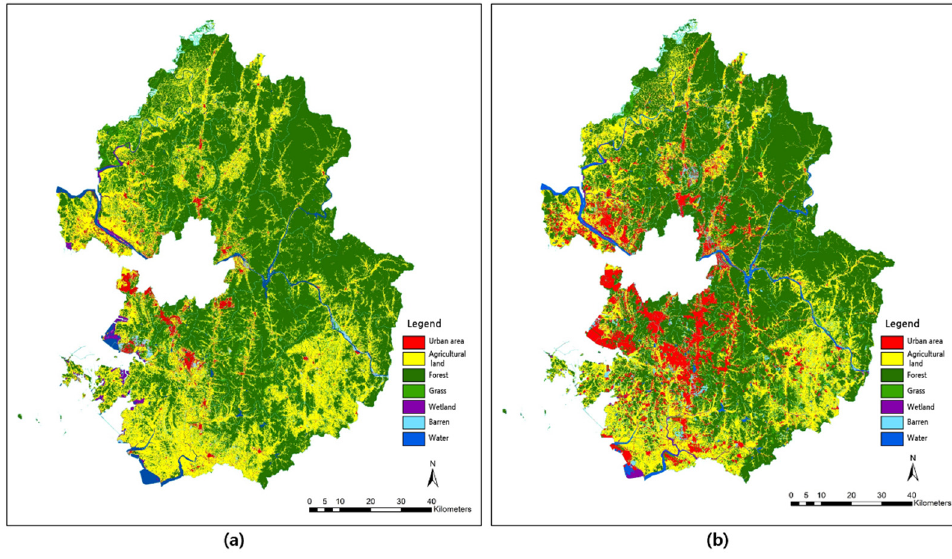
Figure 3. ( a ) Landcover map (1988) and ( b ) land cover map (2018).